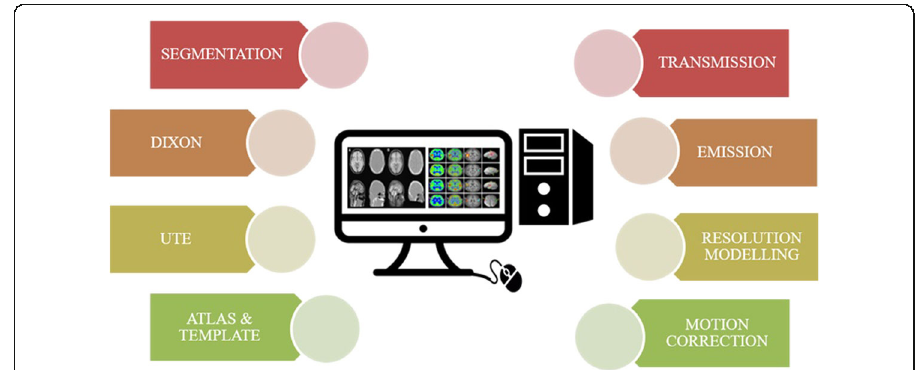
Fig. 6 Various techniques of attenuation correction and reconstruction